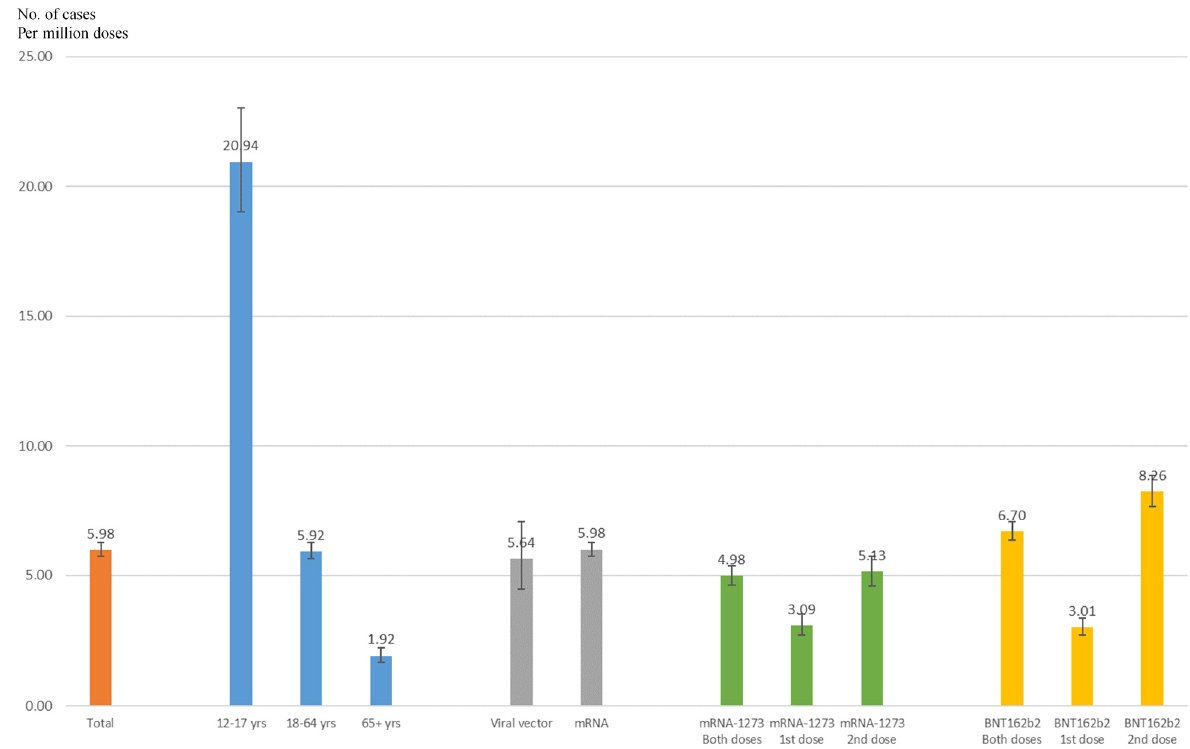
Figure 1. The incidence rate of cases of myocarditis/pericarditis by age and vaccine type. For individual characteristics, cases of myocarditis/pericarditis were more likely to be reported in adolescents (12–17 years) or young adults (18–24 years), males, and those who lived in Northeast or West regions (all p < 0.0001) (Table 1). Cases of myocarditis/pericarditis were more likely to be associated with the BNT162b2 (Pfizer–BioNTech) vaccine ( p < 0.0001) and were more common after the administration of the second dose ( p < 0.0001). Table 1. Characteristics of reports to the VAERS following COVID-19 vaccination by myocardi- tis/pericarditis.